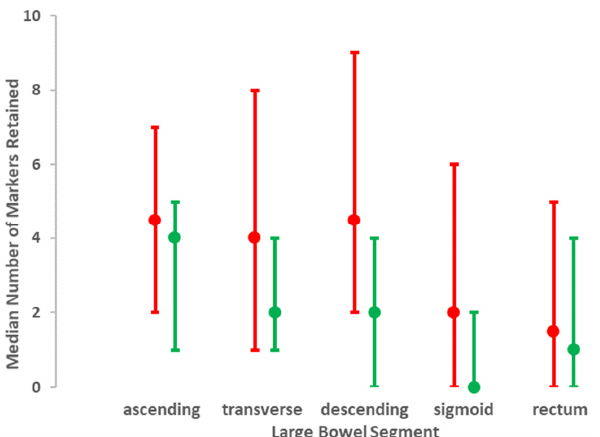
Figure 1. Distribution of markers retained per segment of the large bowel. The median (lower, upper quartile) for each segment is shown for those with diagnosed PD (red) and without (green).